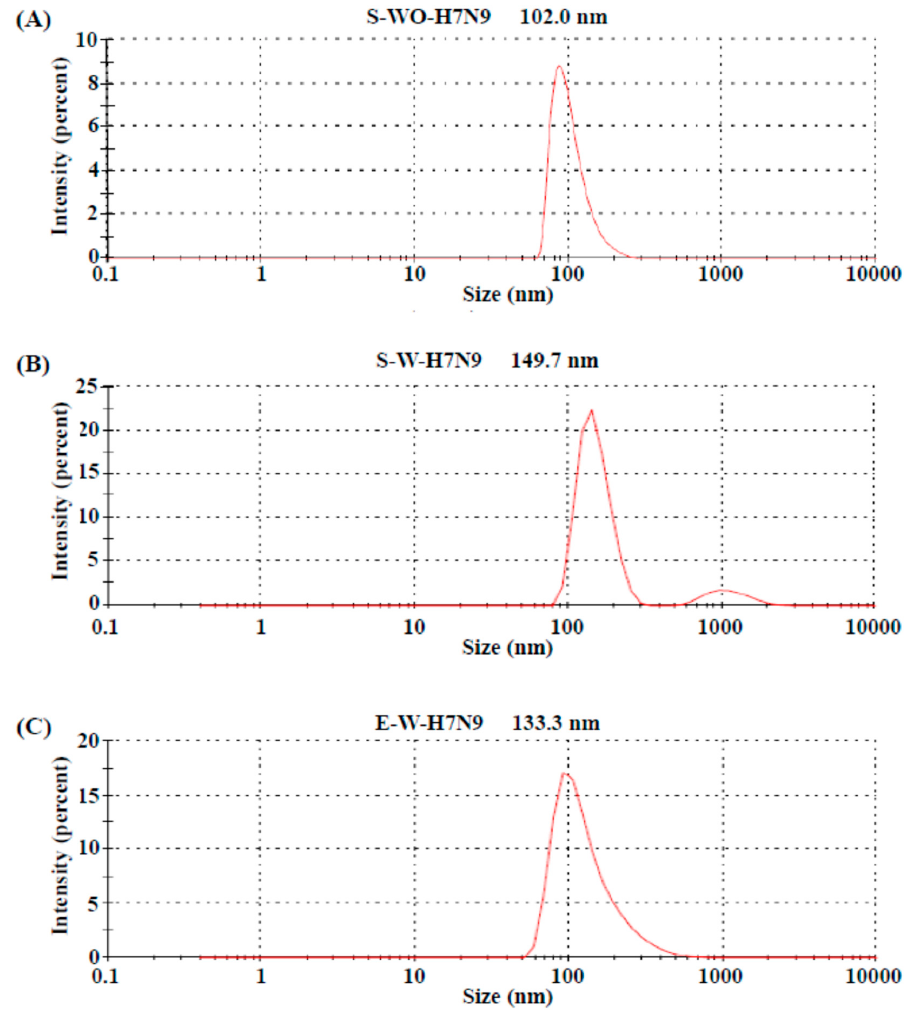
Figure 1. The particle size distribution of three influenza H7N9 vaccine antigens analyzed using dynamic light scattering. ( A ) S-WO-H7N9; ( B ) S-W-H7N9; ( C ) E-W-H7N9. The morphology of the H7N9 vaccine antigens was observed using transmission electron microscopy (Figure 2). All three influenza H7N9 vaccine antigens have similar spherical particles, and the diameters of the three particles were in agreement with the particle size analysis.